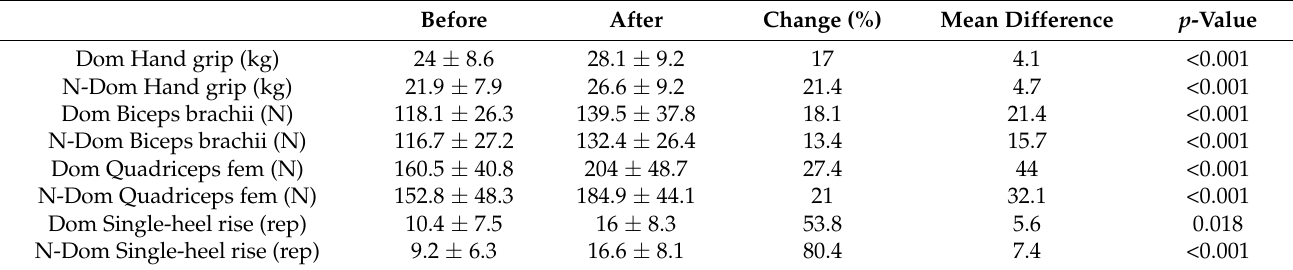
Table 2. Comparison of muscle function before and after training ( n =